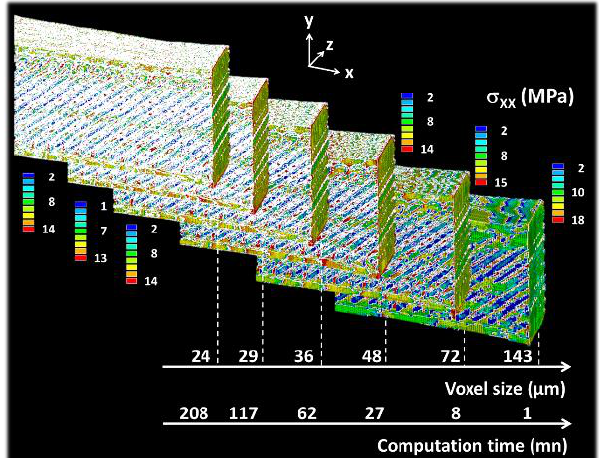
Figure 15. E ff ect of increasing the voxel size on stress component σ XX counterplots (large voxel size Figure 15. Effect of increasing the voxel size on stress component  XX counterplots (large voxel size represents a low resolution, X is the loading represents a low resolution, X is the loading direction).